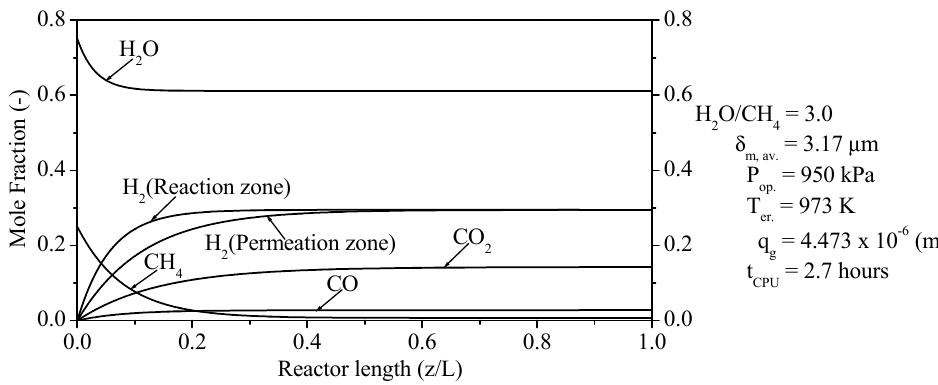
Figure 6. Molar fractions of components i along the reaction zone length from PBMR on Ni/ γ -Al 2 O 3.